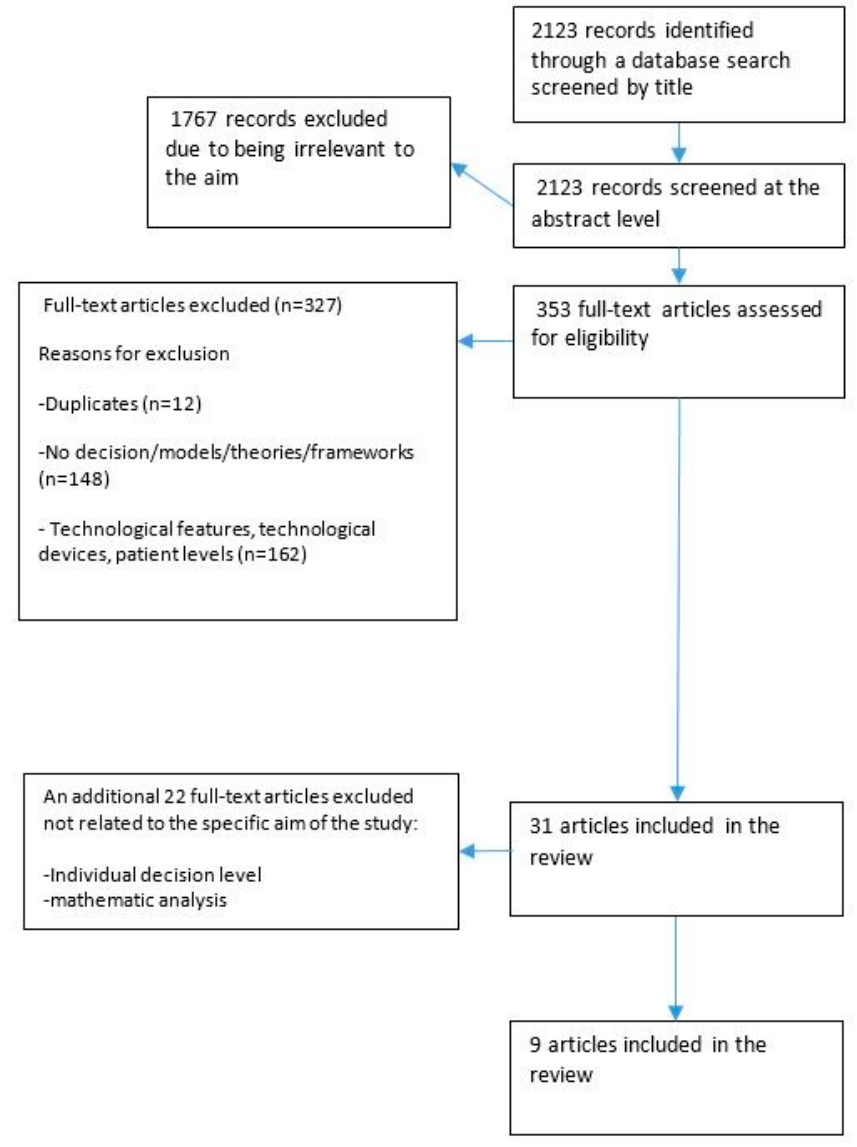
Figure 1. Flowchart of the inclusion and exclusion process.